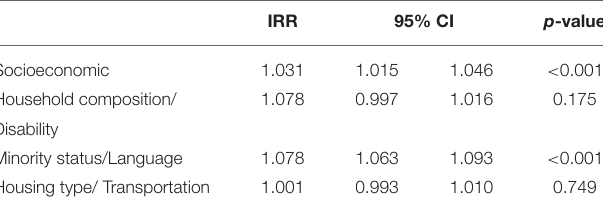
TABLE 4 | The multivariable association of all social vulnerability themes and incidence of SARS-CoV-2 after controlling for stay-at-home measure and testing rate, Harris County, Texas, May 15 to October, 2020 ( n =